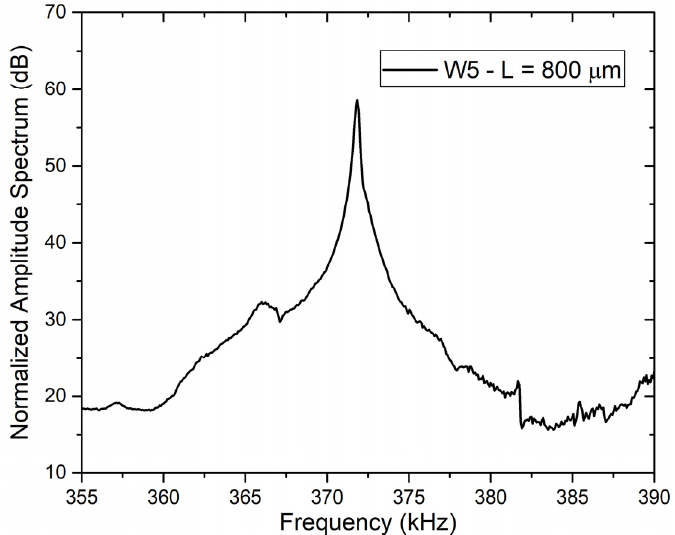
Figure 10. Normalized amplitude spectrum of 800 µm long double clamped beam around its resonance frequency.